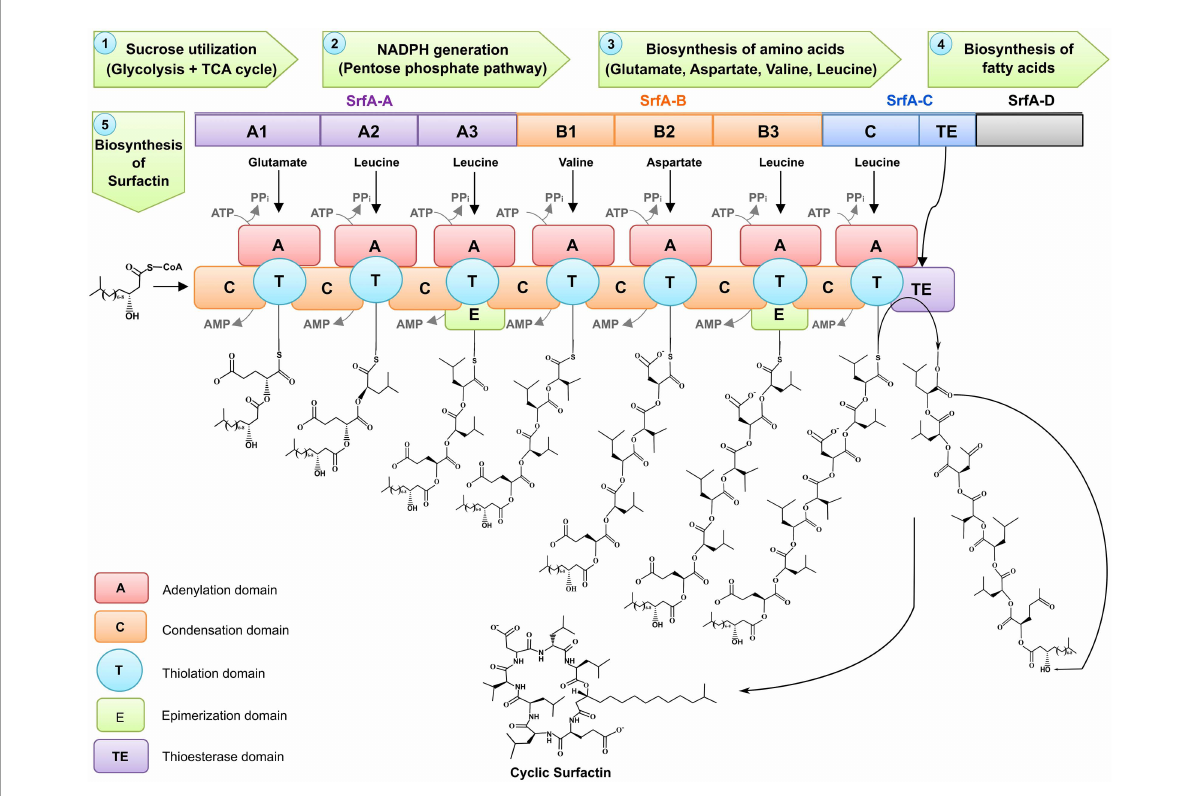
FIGURE6 Biosynthesis of surfactin by Bacillus